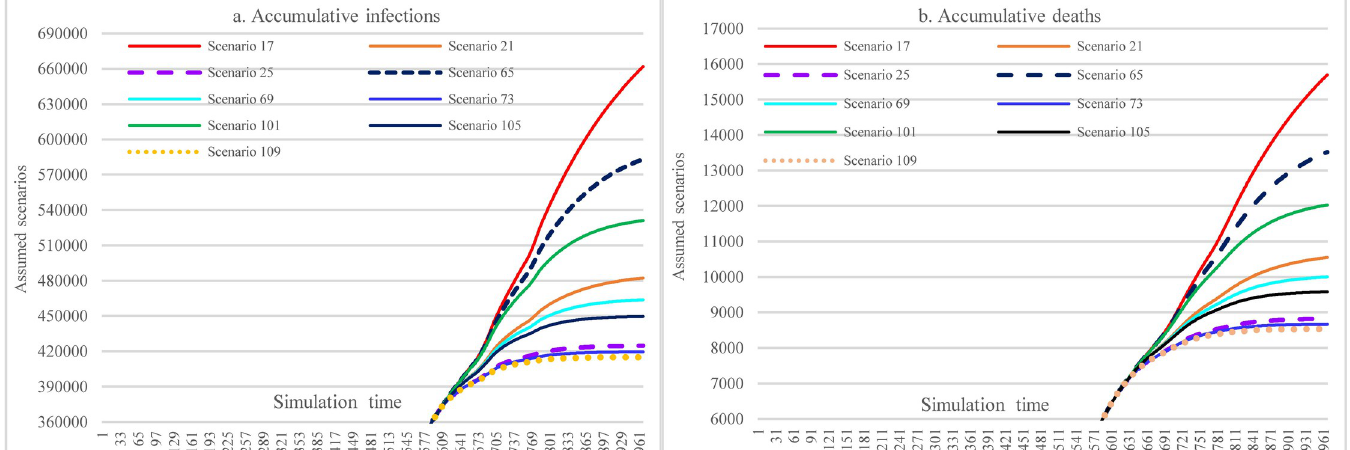
PLOS ONE | https://doi.org/10.1371/journal.pone.0271231 July 26,